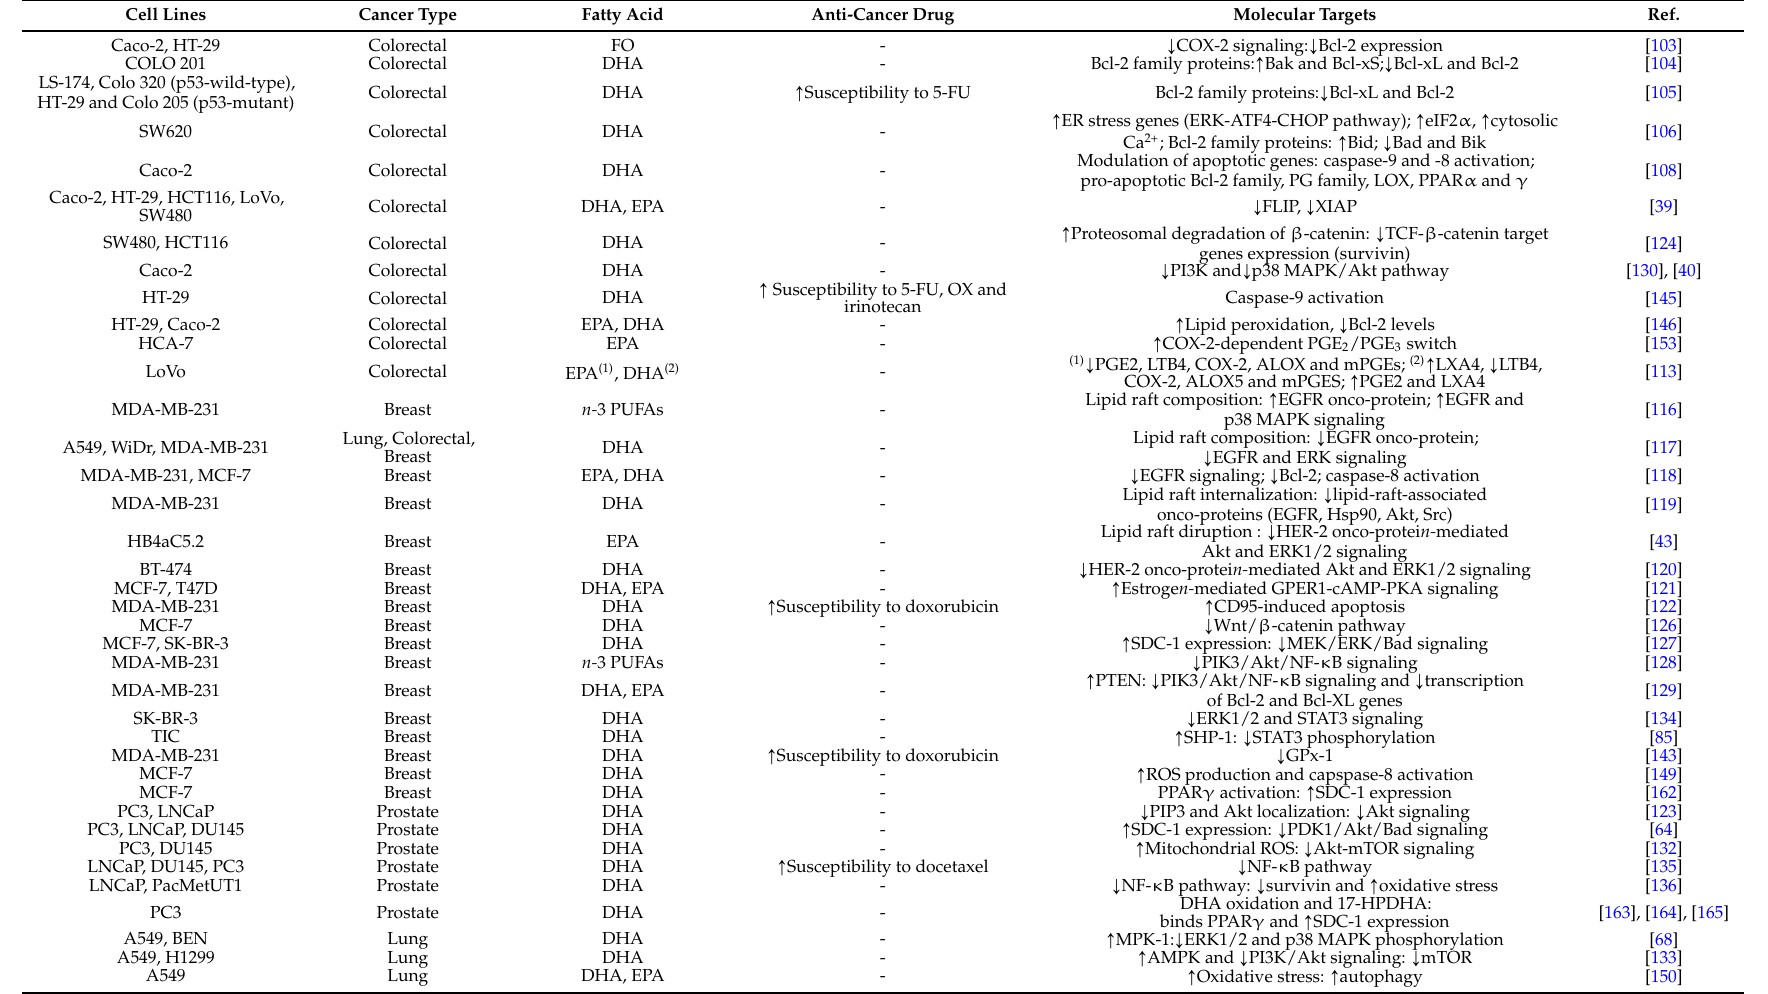
Table 2. Overview of studies investigating the apoptotic targets of n- 3 PUFAs in human tumor cell lines in vitro